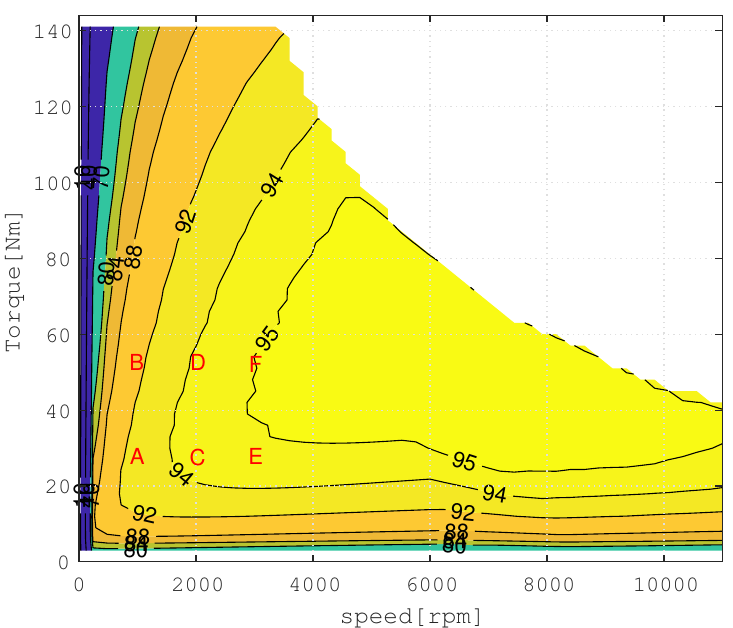
Figure 15. Efficiency map established with FEA while operating with a MTPA control strategy. Letters A-F represent the points verified with calorimetric measurements presented in Table 7.